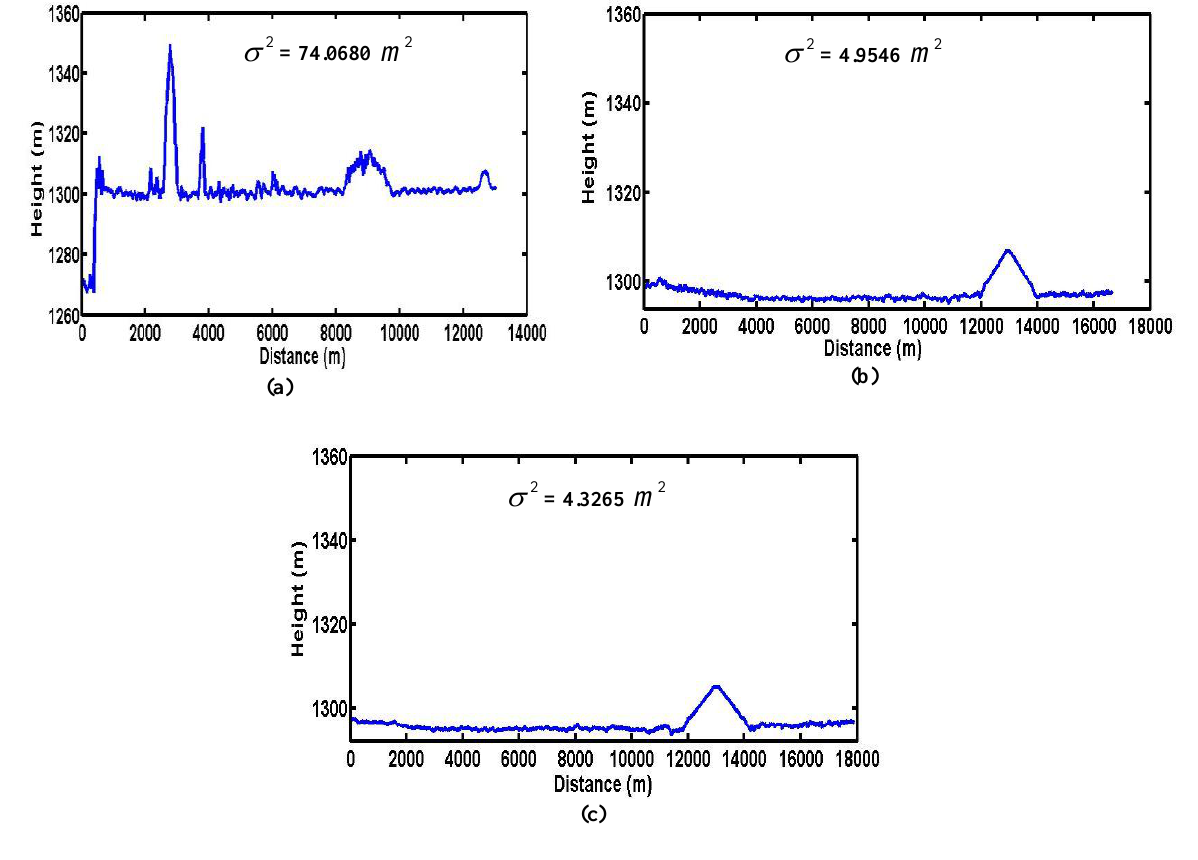
Figure 2. East-west profile along the causeway in TDX DEM generated based on (a) SRTM-X (b) SRTM-C, and (c) NCC